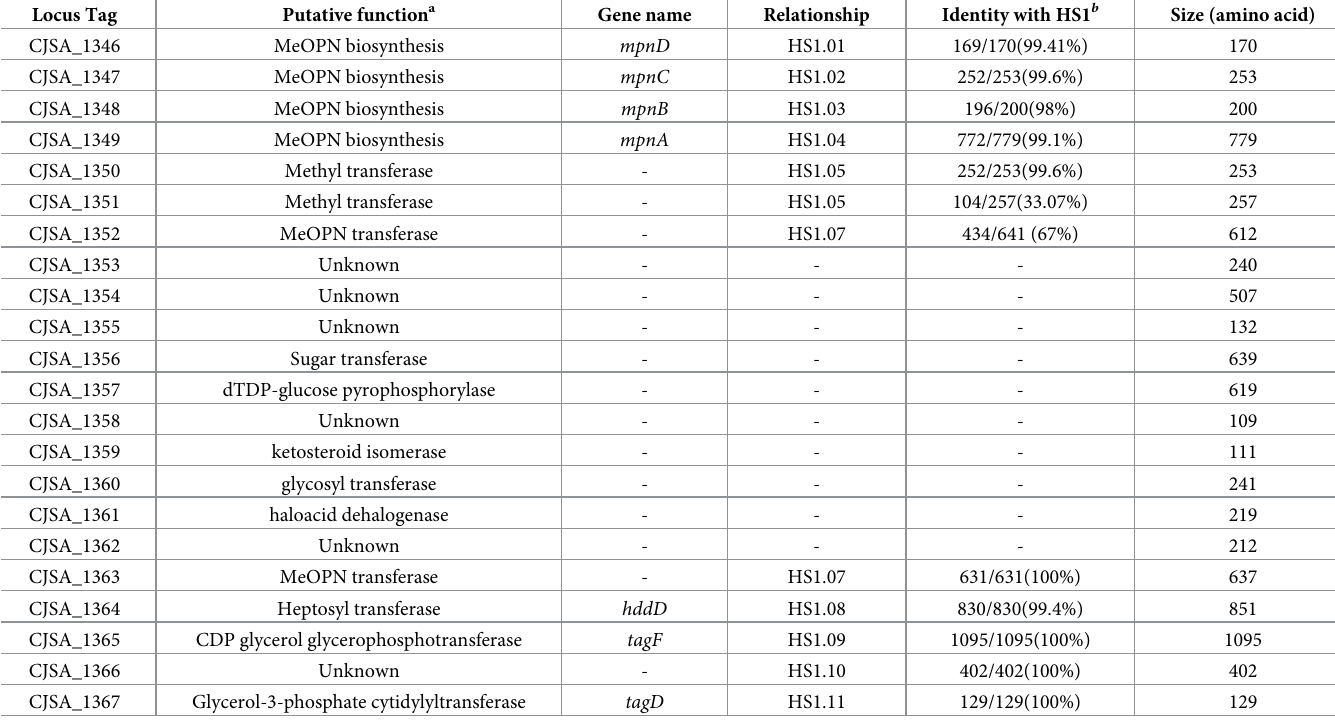
Table 4. Comparison of gene content between C . jejuni IA3902 and HS1 capsule biosynthesis locus. Locus